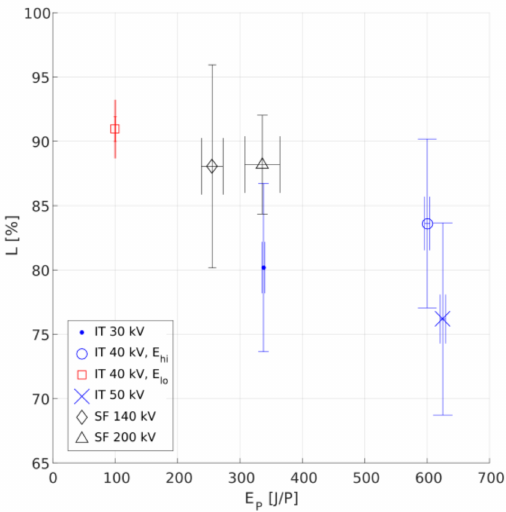
Figure 9. Comparison of liberation (L) and energy of individual discharges (E P ).